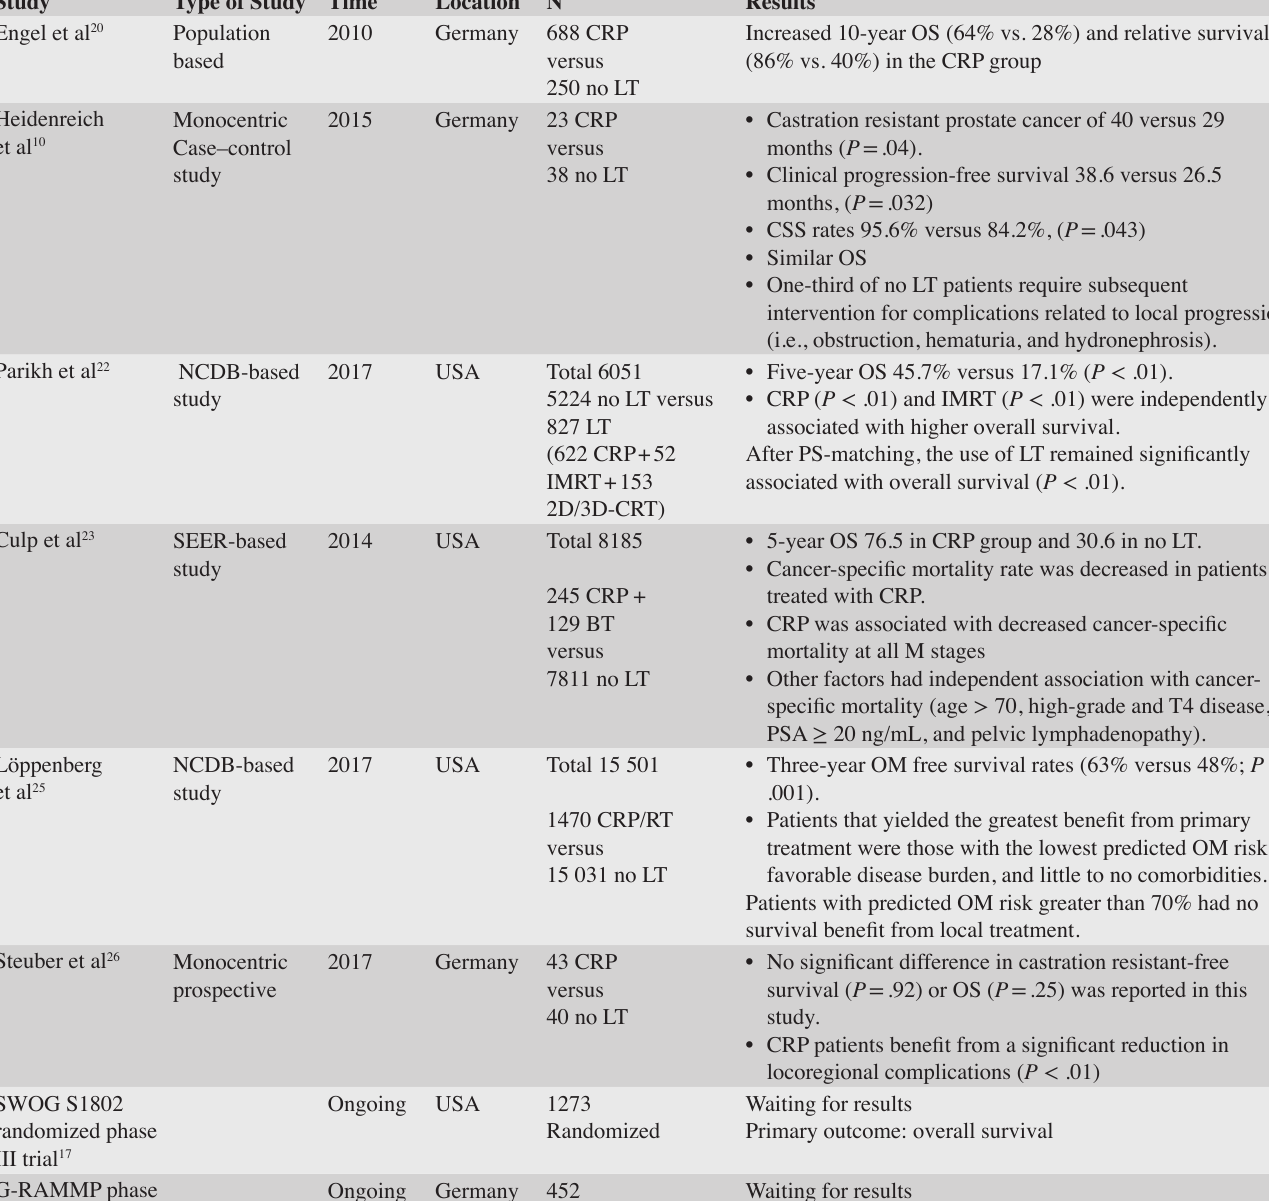
Table 2. Summary of Studies Reporting CRP Oncological Outcomes